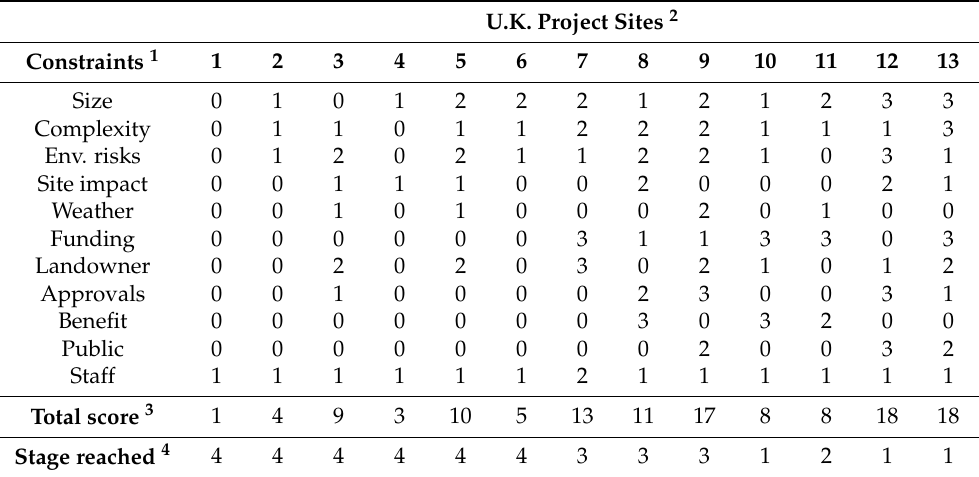
Table 5. The U.K. sites with constraints and the stage reached by the